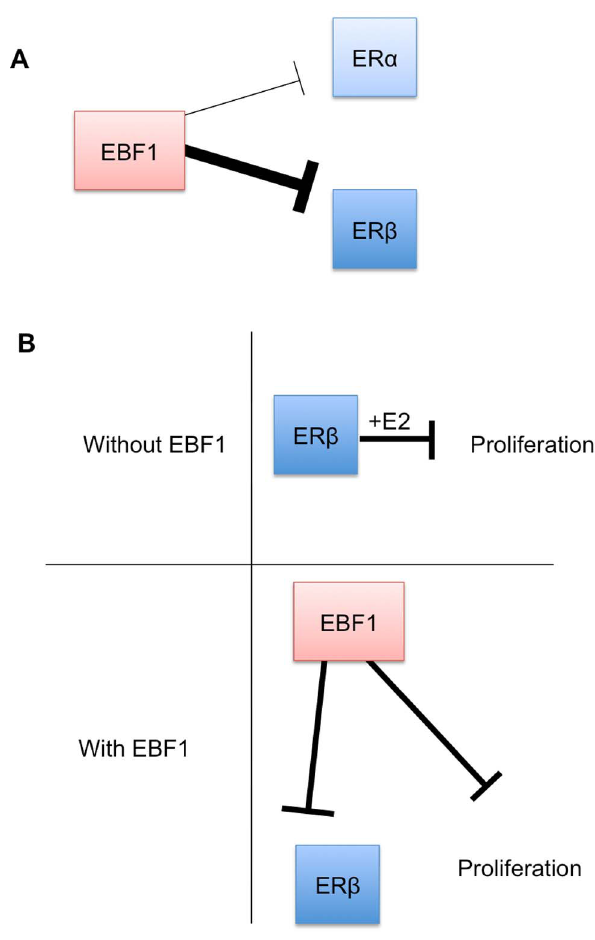
Figure 9. Model of EBF1 antagonistic effects on ERs. A – While EBF1 down regulates both ERs, ER b is more significantly affected by EBF1. B – In the absence of EBF1, ER b suppresses cell proliferation upon E2 activation. When EBF1 is present, EBF1 down regulates ER b levels, rendering the cells hormone insensitive. However, EBF1 also suppresses cell proliferation, independent of ER b